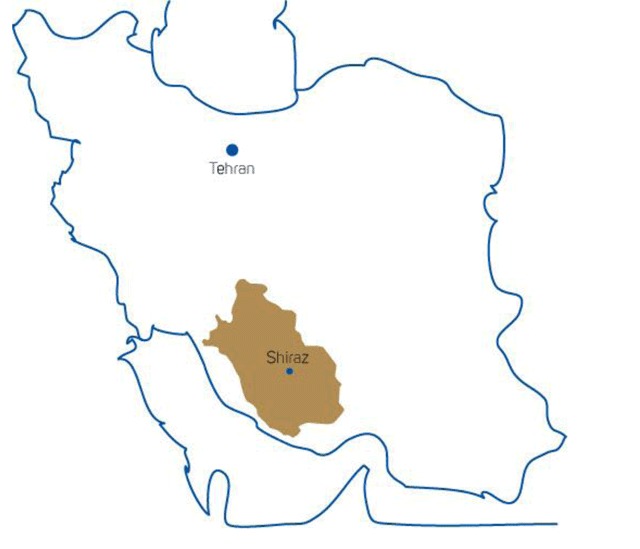
Map of the study areas.